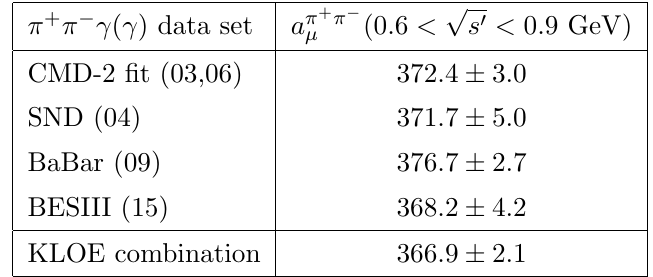
p (0 : 6 < s 0 < 0 : 9 GeV) from the (cid:22) are given in units of (cid:22)